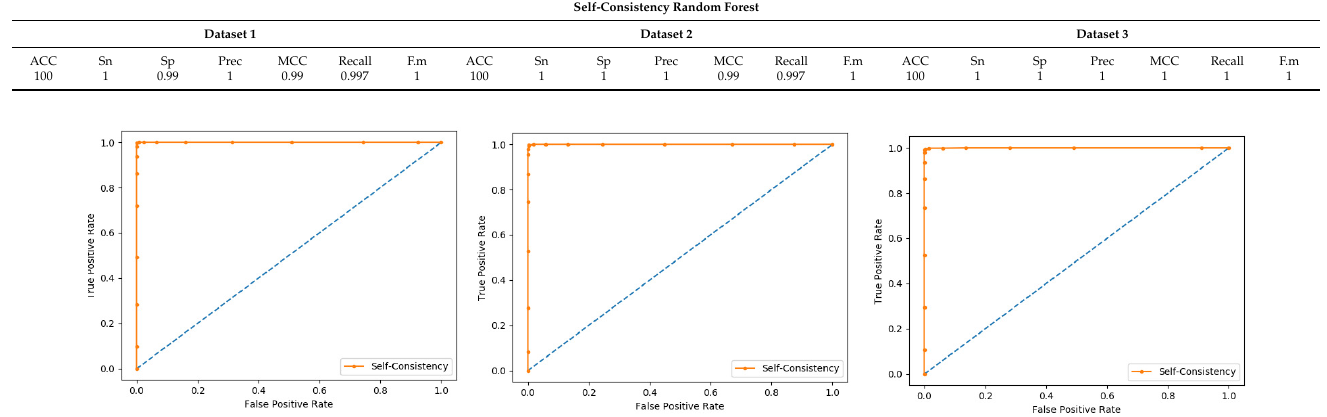
Table 6. Results of self-consistency based on Random Forest. Figure 10. Self- consistency Random Forest ROC curve.